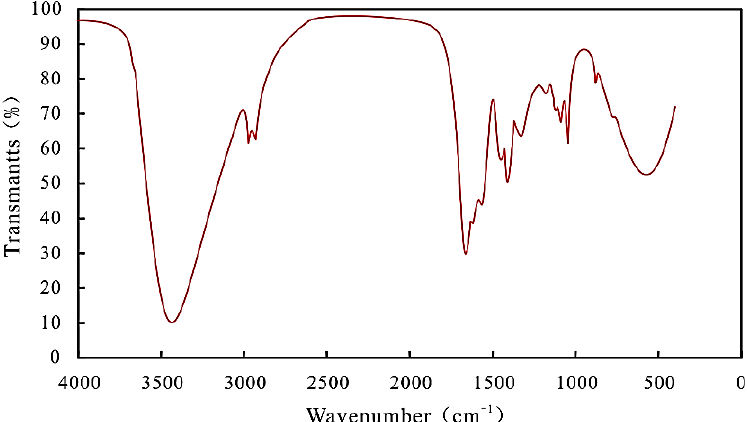
Figure 2. Infrared spectrum of polymer.